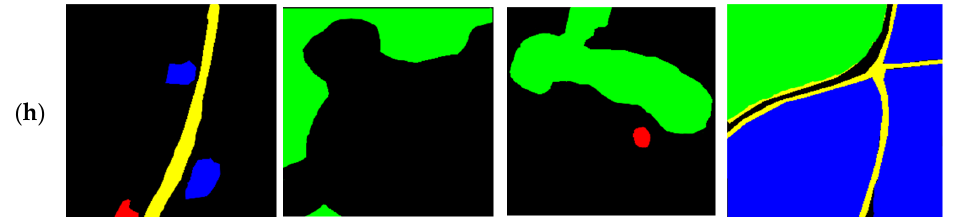
Figure 7. Model prediction results: ( a ) SAR image, ( b ) optical image, ( c ) tag image, ( d ) X = 2, ( e ) X = 3, ( f ) X = 4, ( g ) X = 5, ( h ) X = 6.